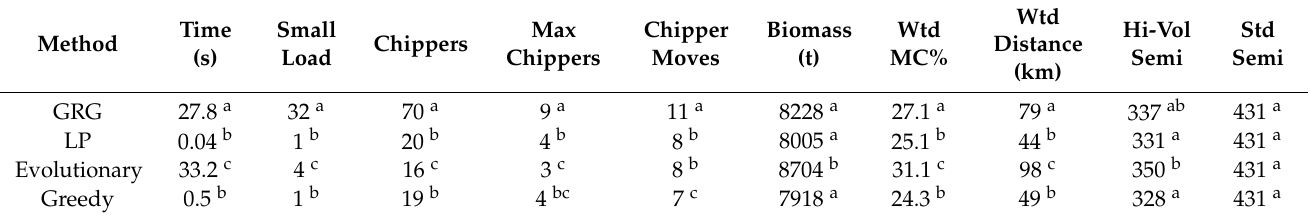
Table 4. Mean test criteria values (non-cost) for each tested method.